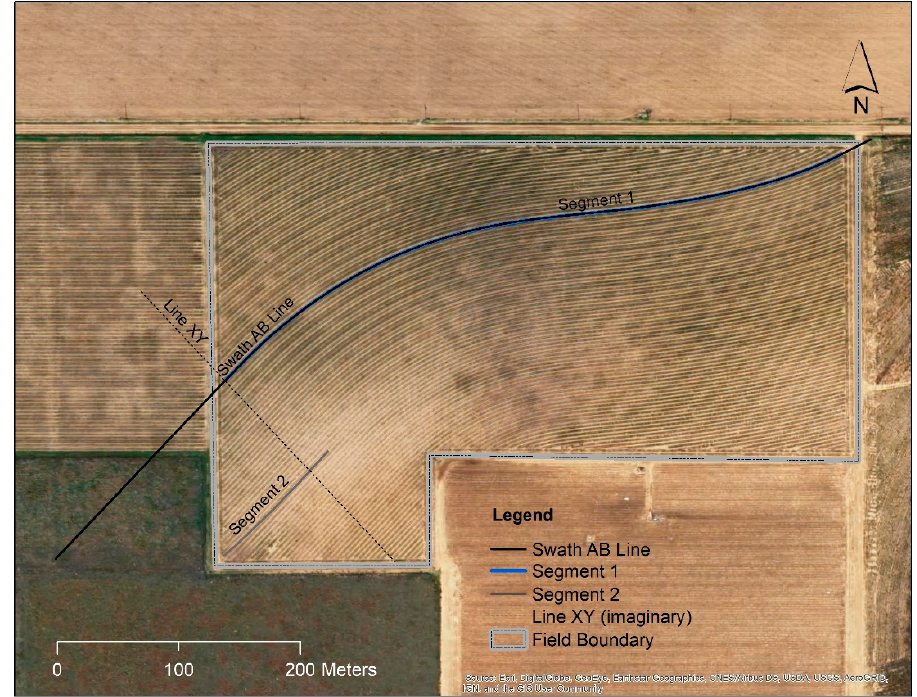
Figure 5. Merging multiple AB lines for simplified guidance operations.